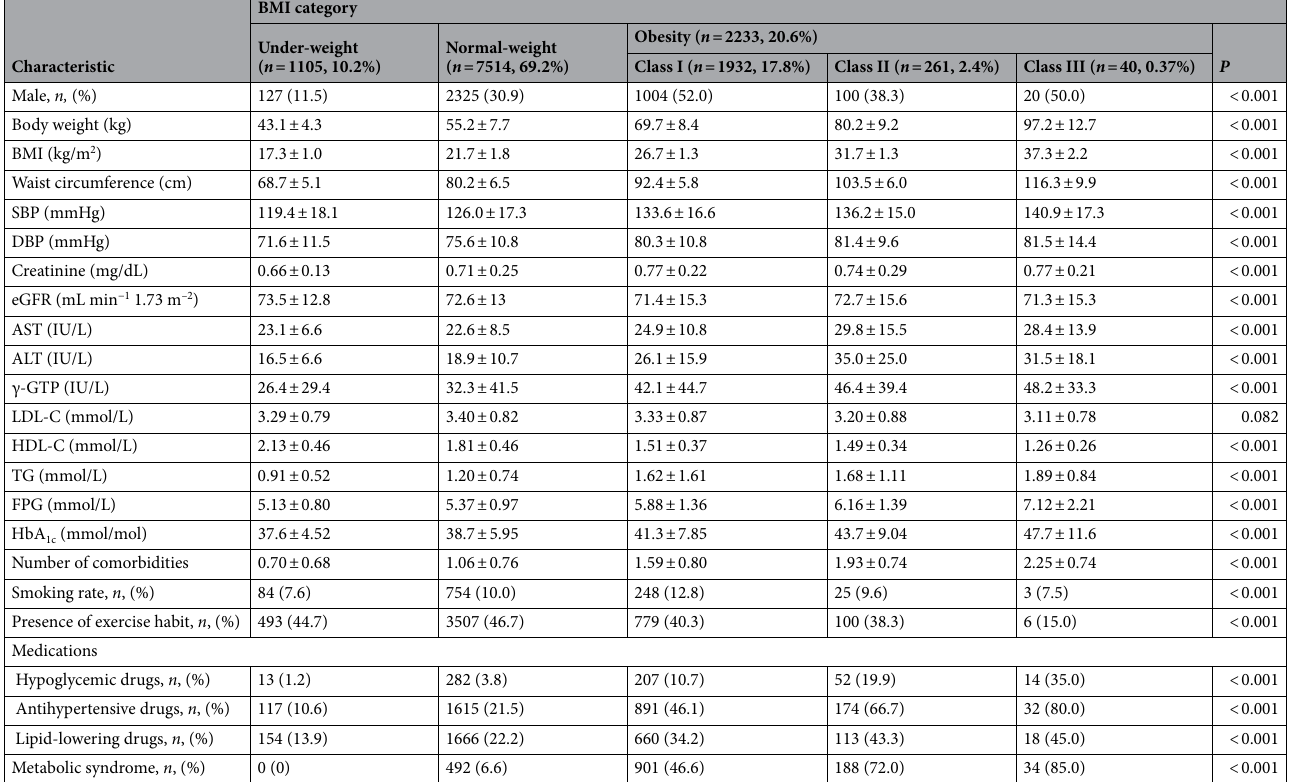
Table 2. Characteristics of the study participants according to BMI category. Data are means ± SD or n (%). All abbreviations are defined in the text. P values were calculated with the Jonckheere–Terpstra trend test or the Armitage trend test as